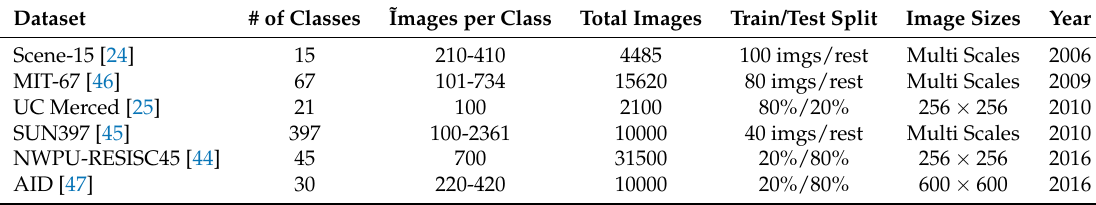
Table 1. Comparison of the six remote sensing datasets used in this